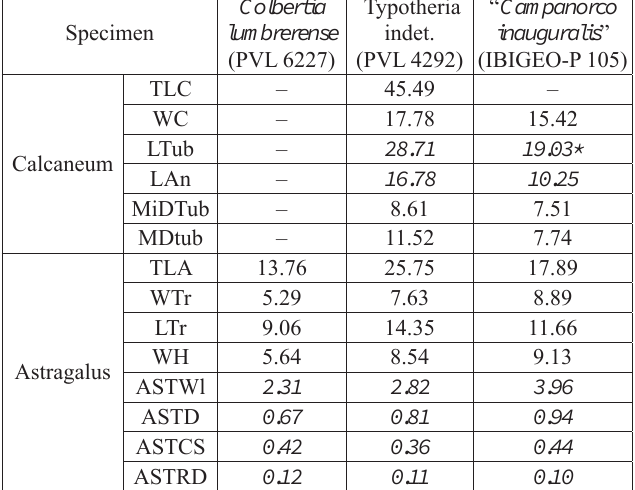
Table 1. Measurements (in mm) of the proximal tarsals described in the text. After Armella et al. (2016: fig. 3.3, 4): LAn, length of the anterior region of the calcaneum; LTr, length of the trochlea; LTub, length of the tuber calcis; MDTub, maximum diameter of the tuber calcis; MiDTub, minimum diameter of the tuber calcis; TLA, total length of the astrag- alus; TLC, total length of the calcaneum; WC, width of the calcaneal body; WH, width of the astragalar head; WTr, width of the trochlea. Values in italics after Carrano (1997: fig. 2C): ASTCS, astragalar con- dyle symmetry (ASTW1/ WTr); ASTD, depth of the astragalar troch- lea; ASTRD, astragalar trochlea concavity (ASTD/WTr); ASTW1, width of medial condyle. – measurement not available; *